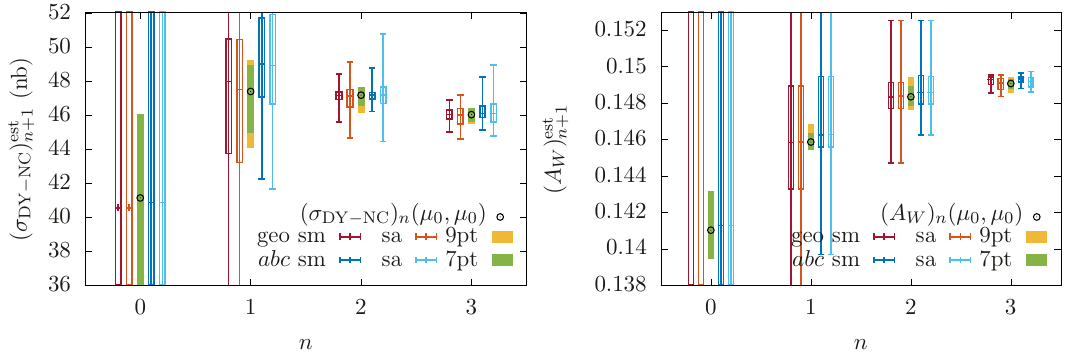
Figure 17 . The 68% and 95% CIs for the neutral-current Drell-Yan cross-section and charged- current lepton-charge asymmetry for the geometric and abc -models using the sa- and sm- prescriptions. The scale variation intervals using 7 and 9 points are shown for